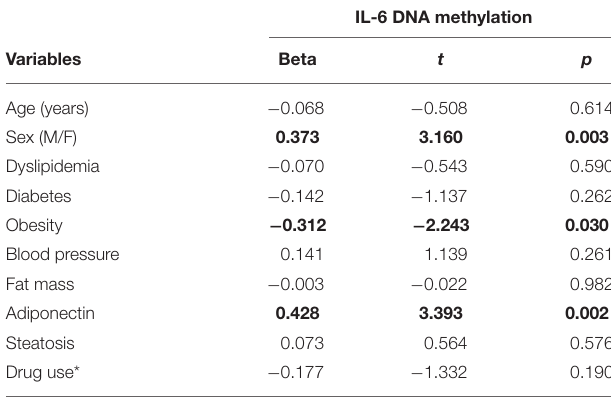
TABLE 2 | Linear regression analysis with IL-6 DNA methylation as the dependent variable.